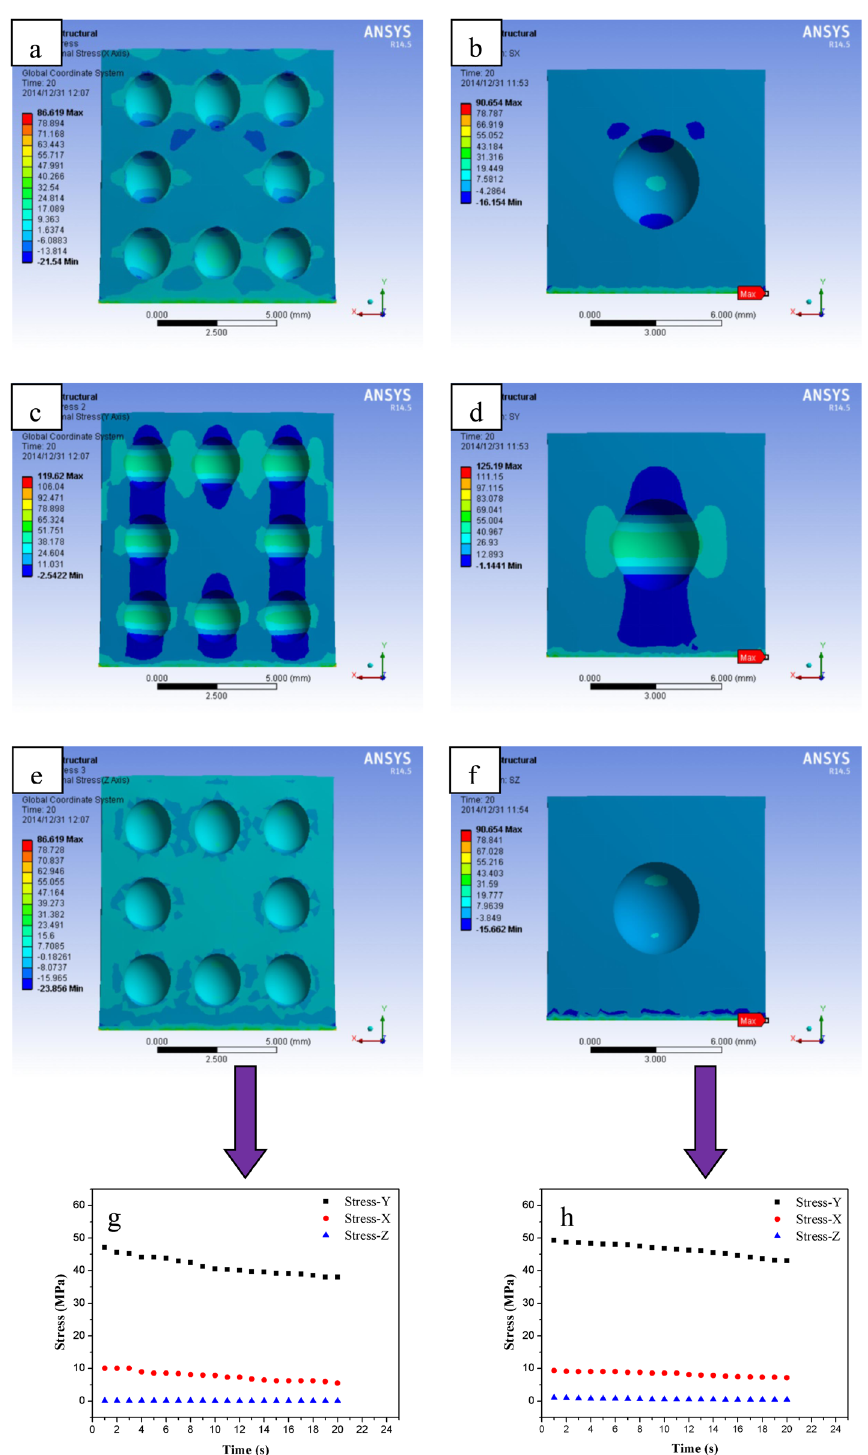
Figure 8: Three - dimensional stress analysis of foamed samples with small ( a, c, e and g ) and large ( b, d, f and h ) cell sizes: ( a and b ) along x direction, ( c and d ) along y direction, ( e and f ) along y direction, ( g and h ) along the x , y , and z